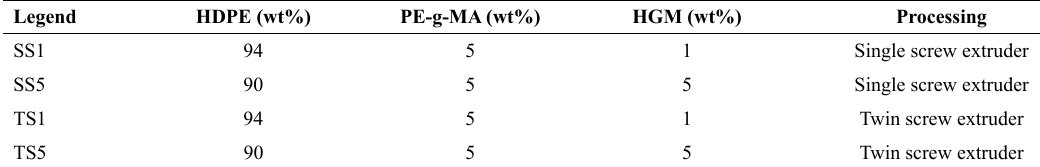
Table 1. Composite formulation